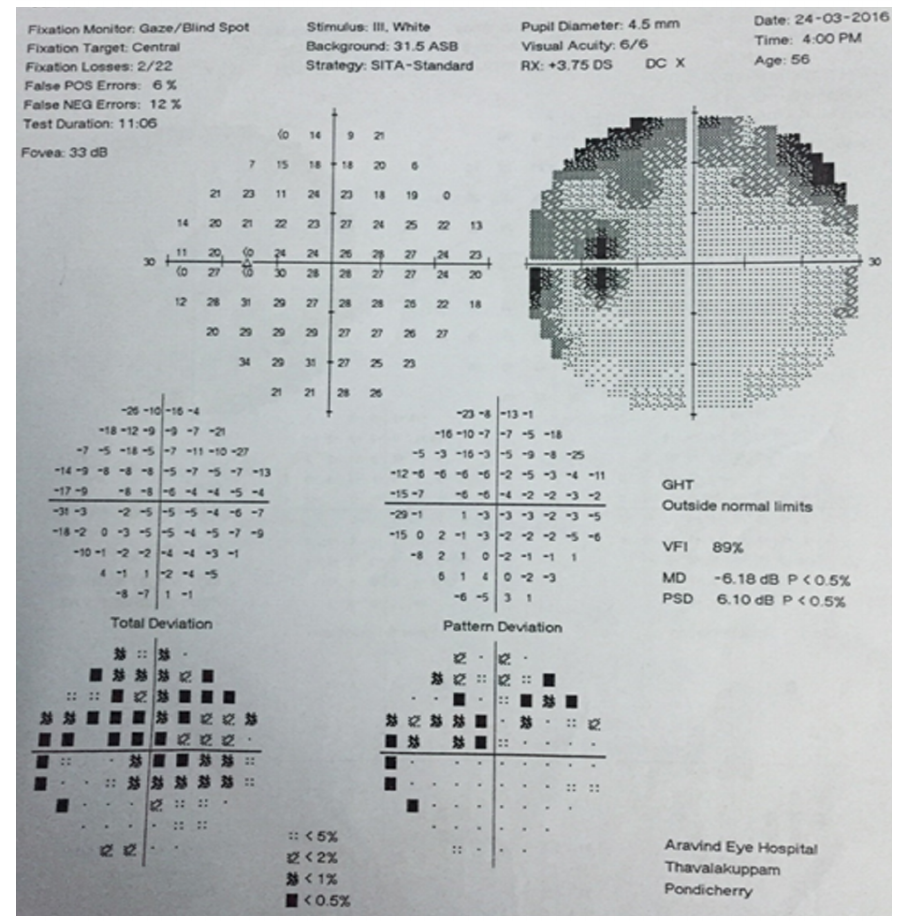
Figure 3: Humphrey field analysis 30-2 showing left superior arcuate